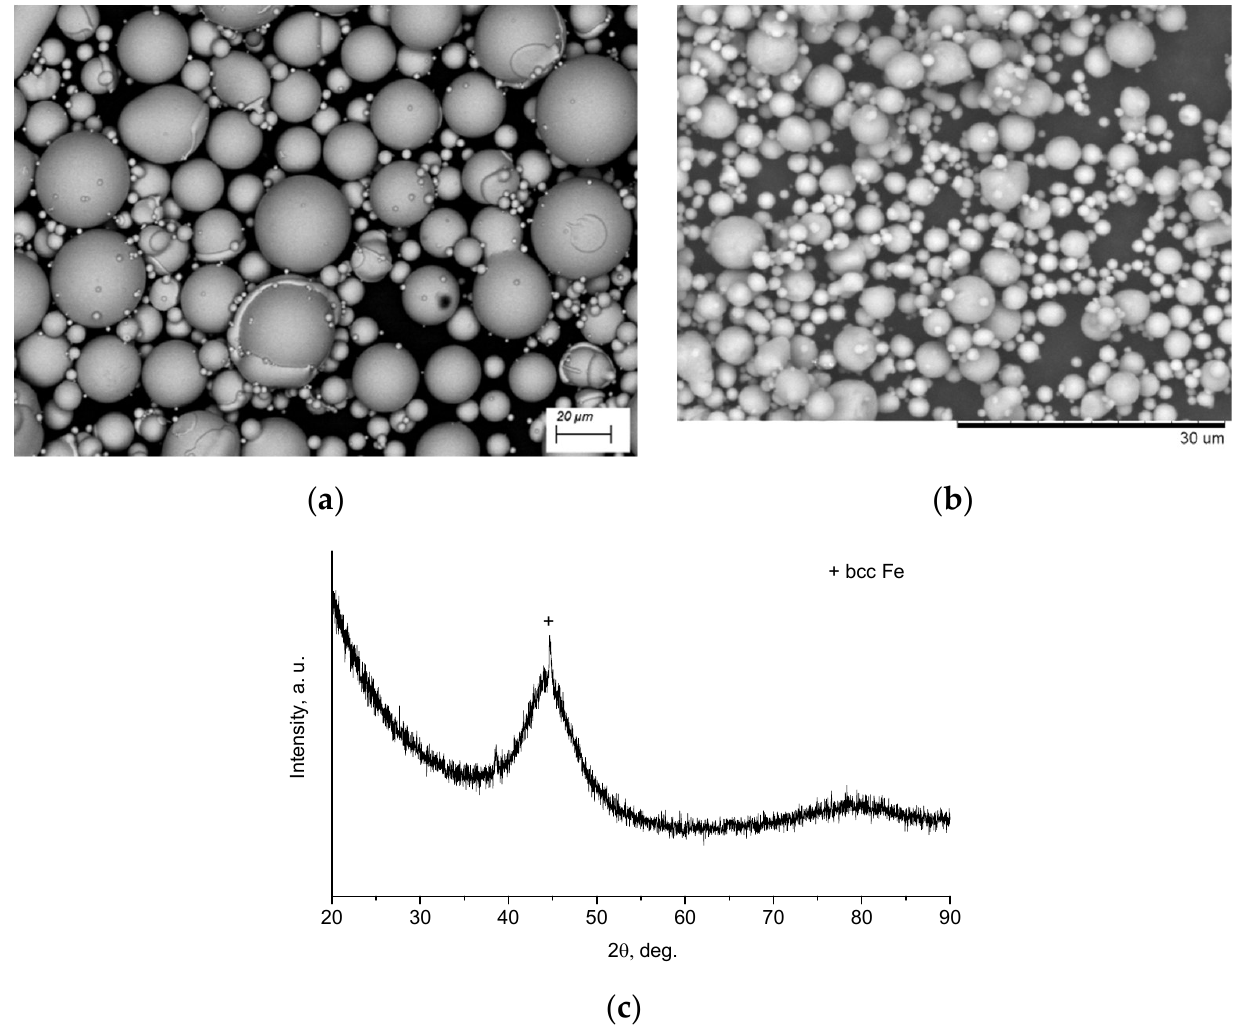
Figure 1. ( a ) Scanning electron microscopy (SEM) image of the Fe 66 Cr 10 Nb 5 B 19 metallic glass powder, back-scattered electron (BSE) image, ( b ) SEM image of the aluminum powder, back-scattered electron image, ( c ) X-ray diffraction (XRD) pattern of the Fe 66 Cr 10 Nb 5 B 19 metallic glass powder. The minor phase in the alloy is body-centered cubic iron (bcc-Fe).